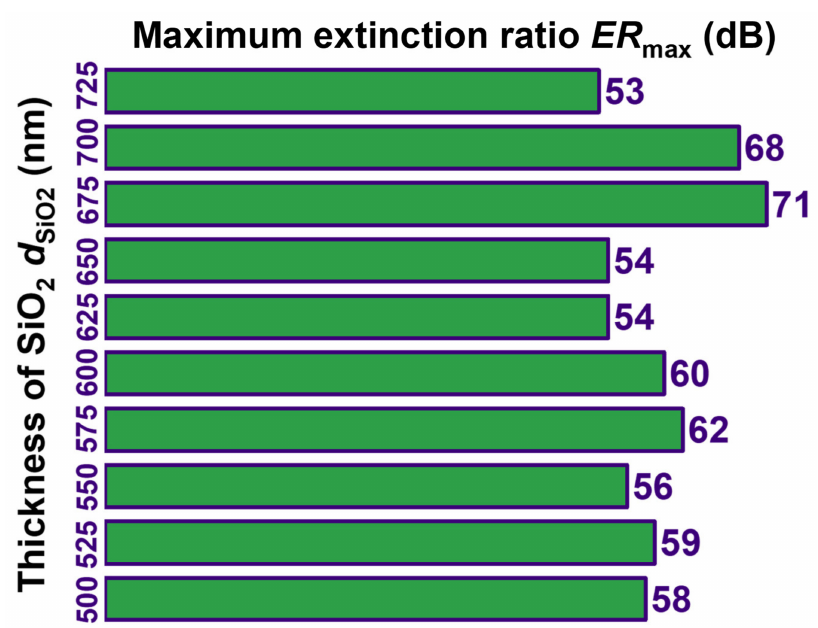
from 725 to 500 nm 2